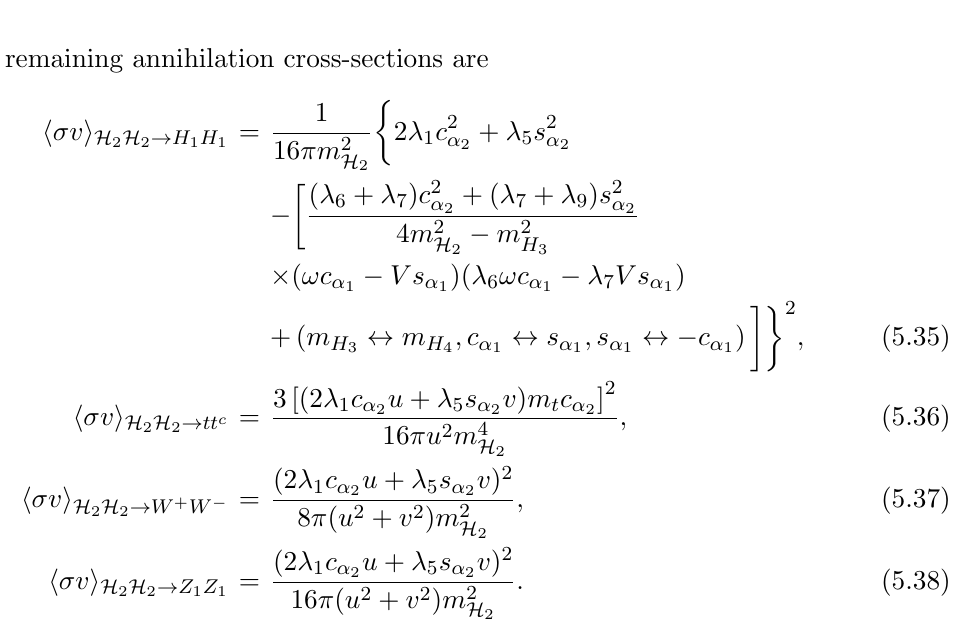
Figure 9 . Conversion between two-component scalar dark